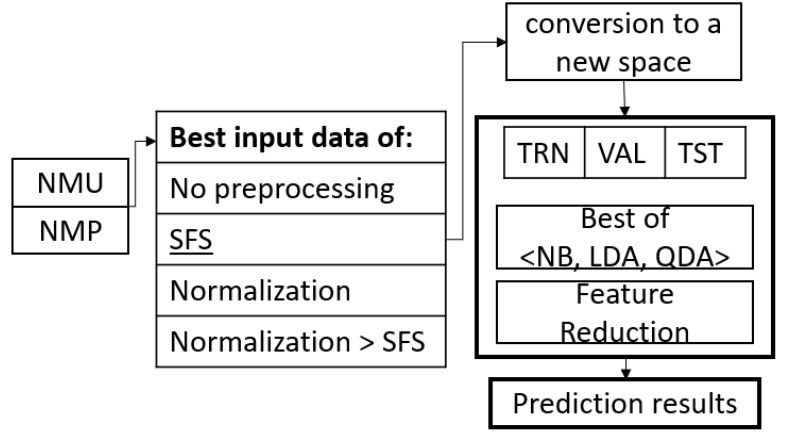
Figure 6. Creation of the classification model after selection of the best preprocessing from the conversion into a new space.